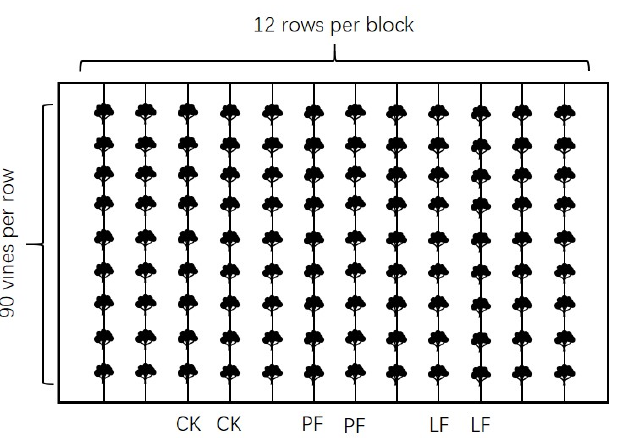
Figure 2. The experimental setup of each block as replicate. Notes: Two rows per treatment. A total of 90 vines per row. The treatments were arranged in nonadjacent rows. The experimental setup had three such blocks.